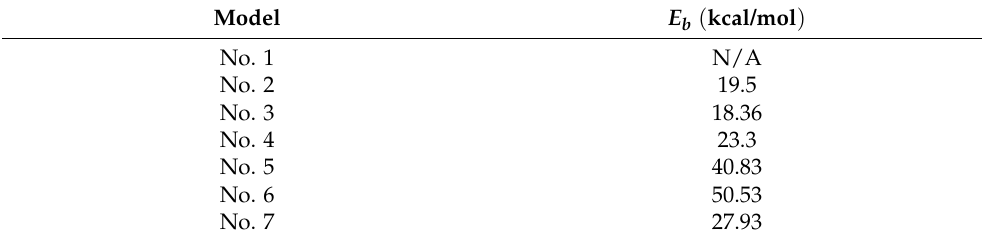
Table 3. Binding